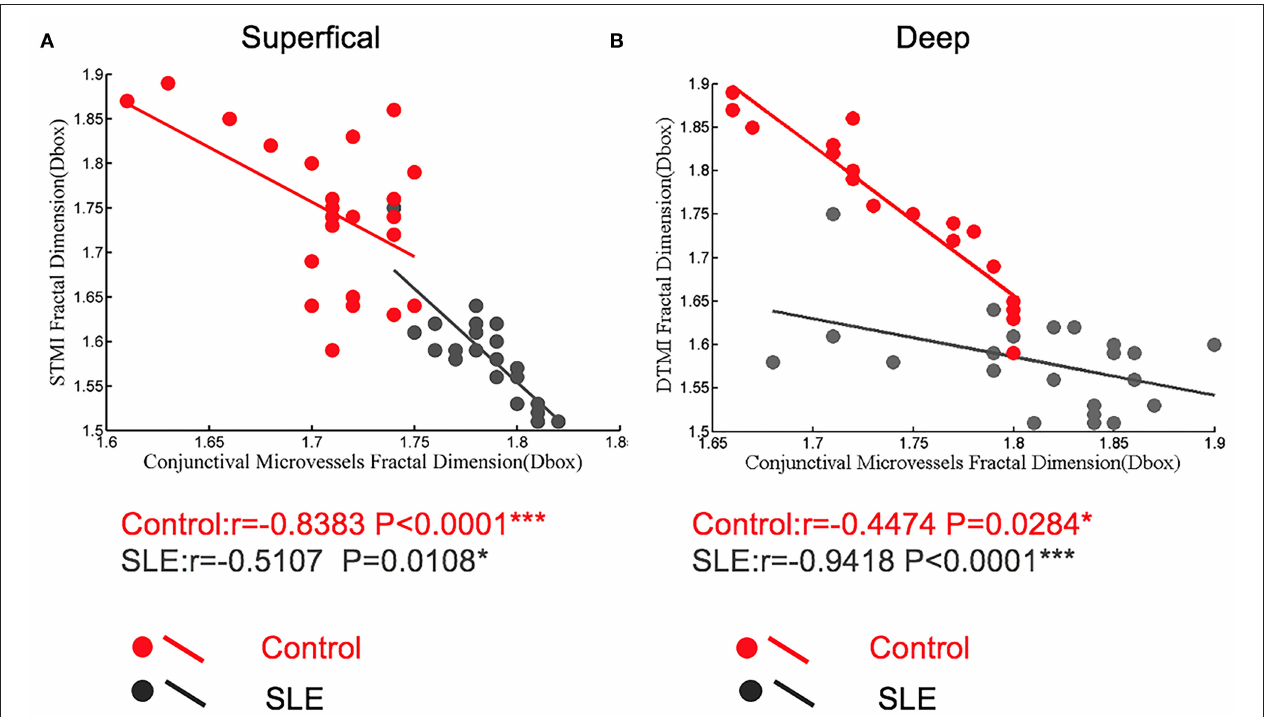
FIGURE 7 | The correlation between conjunctiva microvascular density and retinal microvascular density in control and SLE patients. (A) In the superficial retinal layer; (B) In the deep retinal layer. * P < 0.05, *** P <